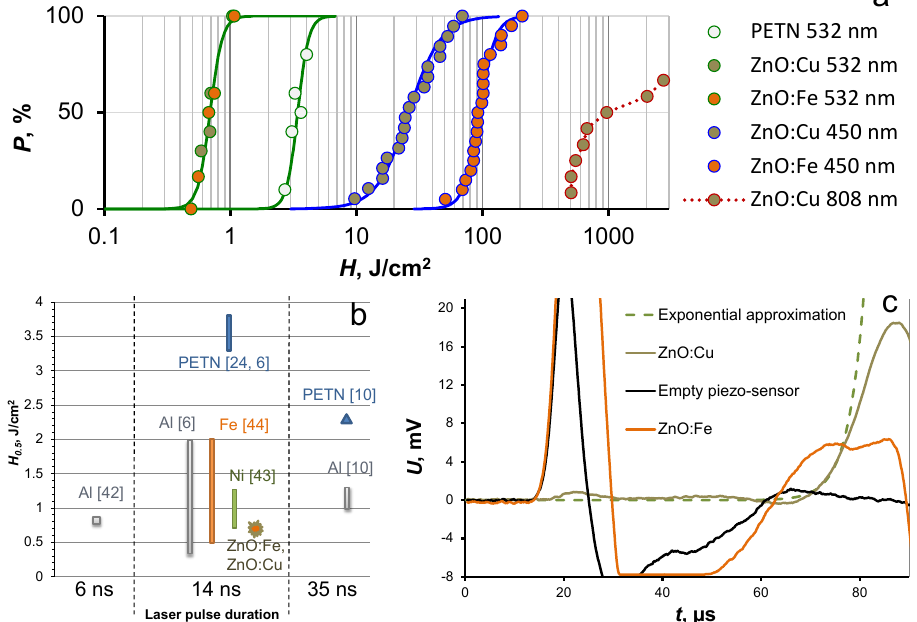
Figure 5. Explosion probability curves of the pure PETN, PETN − ZnO:Fe, and PETN − ZnO:Cu composites initiated by second harmonic of the YAG:Nd laser (532 nm), CW laser diodes with wavelength 450 and 808 nm ( a ). Comparison of the threshold energy density of the PETN − ZnO:Cu and ZnO:Fe (532 nm) and PETN (532 and 1064 nm) composites with iron (Fe; 1064 nm), nickel (Ni; 1064 nm), and aluminum (Al; 1064 and 532 nm) nanopowders initiated by nanosecond pulsed laser radiation ( b ). Oscillograms of photoacoustic response from the PETN − ZnO:Fe and PETN − ZnO:Cu composites ( c ).